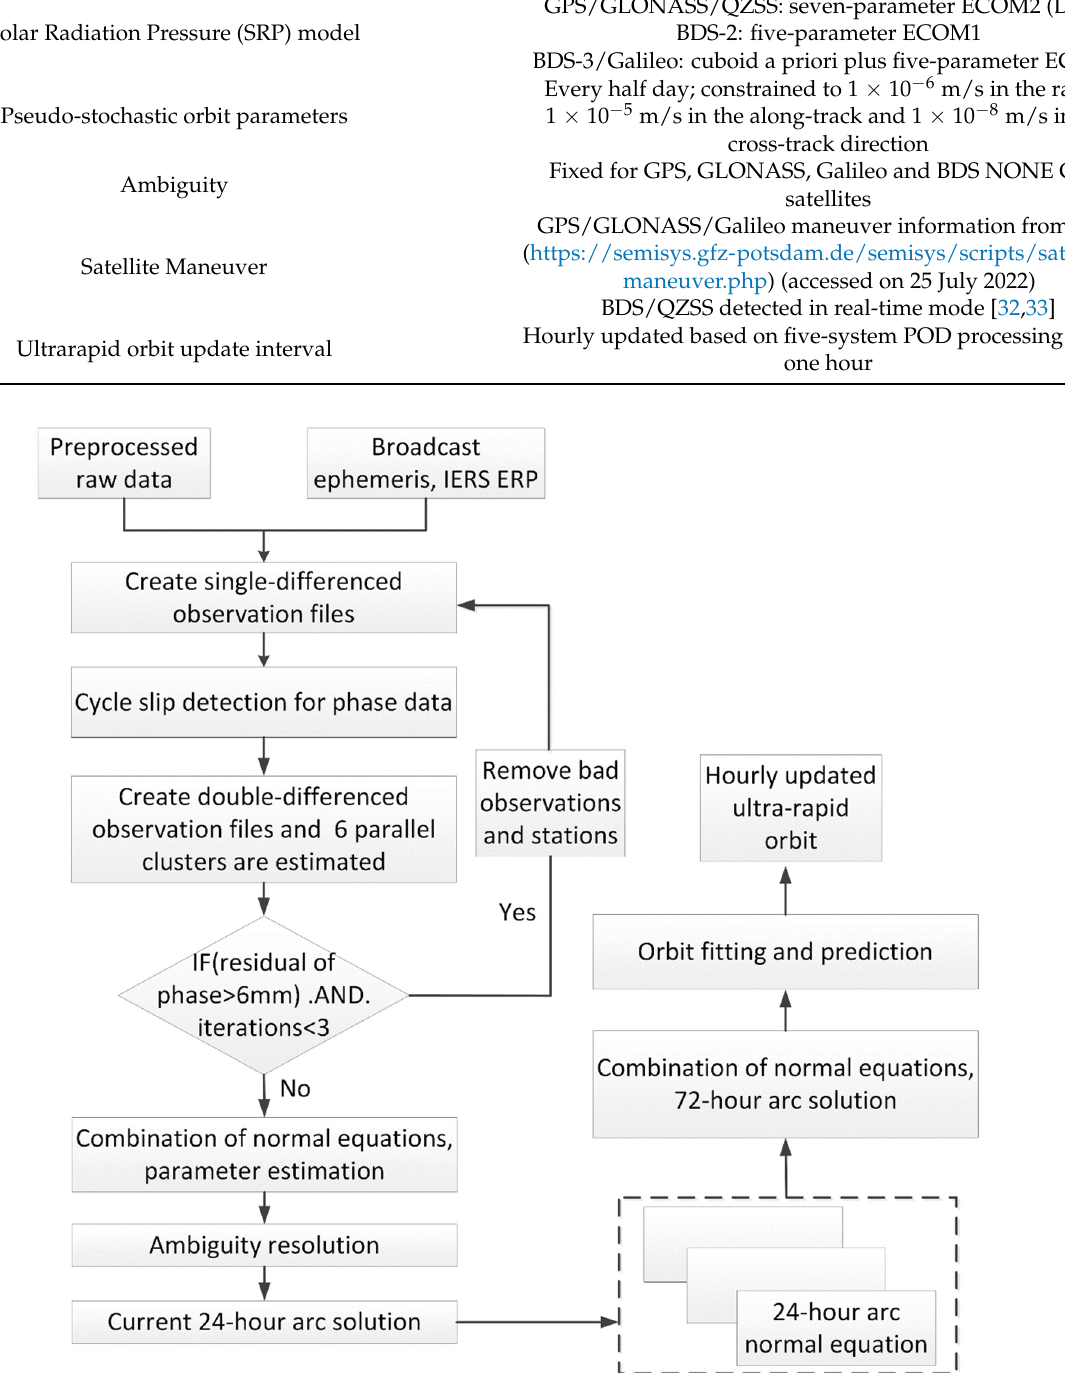
Figure 3. Flowchart of the procedure for real-time multi-GNSS POD.